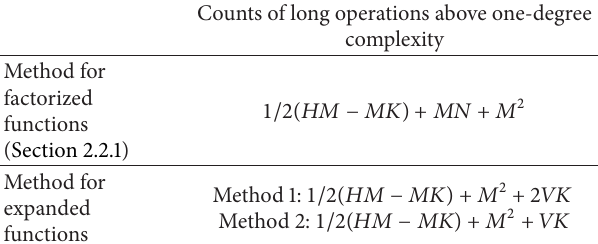
Table4:Countsoflongoperationsaboveone-degreecomplexityfor a proper